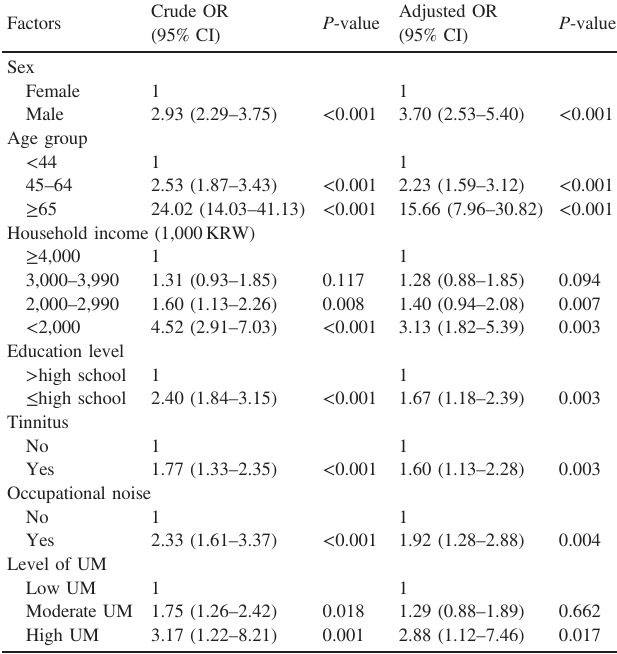
Table 4. Final logistic regression model for evaluating the association with a hearing loss of >